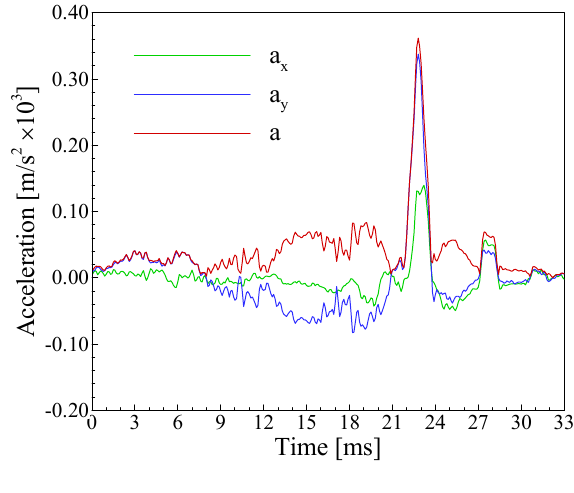
Figure 12. Time histories of the termite head acceleration in a 33-ms head-banging